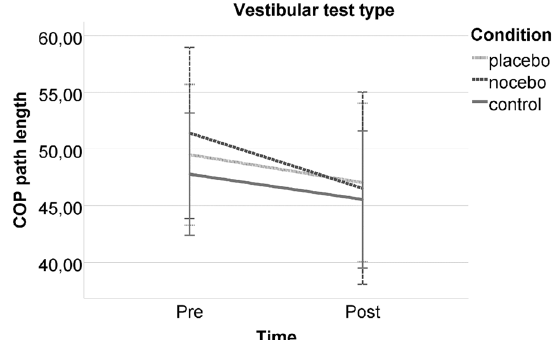
Fig. 2 Postural stability performance of the experimental groups pre- and post-intervention in the standard test type. Note: The error bars reflect 95% CI